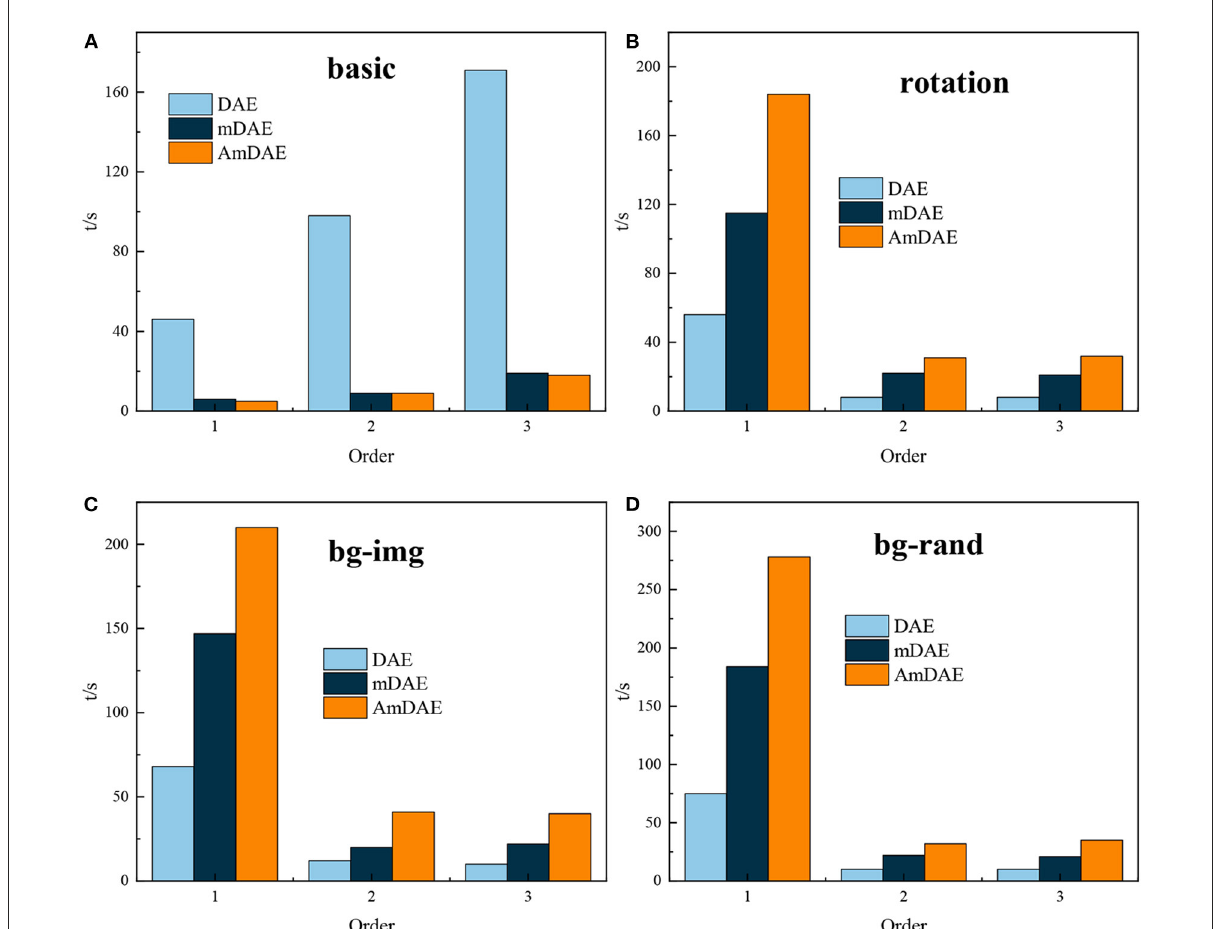
FIGURE6 Time required for model training. (A) basic model, (B) rotating model, (C) background image, and (D) offset